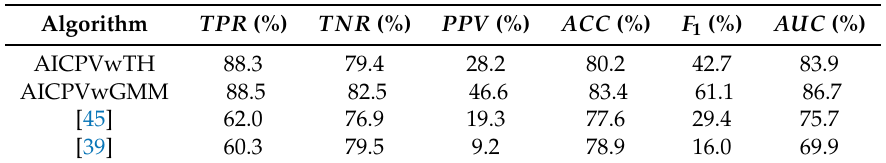
Table 3. Comparison of performance over a 30-patient test data set between the rule-based threshold classifier (AICPVwTH), the proposed Gaussian Mixture Models (GMM) classifier (AICPVwGMM), and two previous related studies.